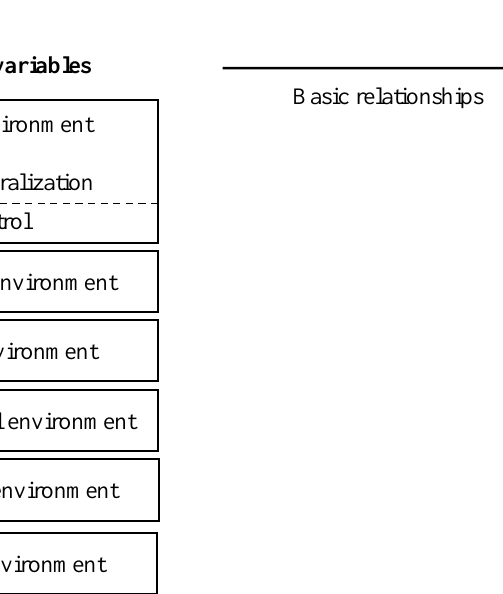
Figure 4. Relationship between variables in the hypothetical-deductive research